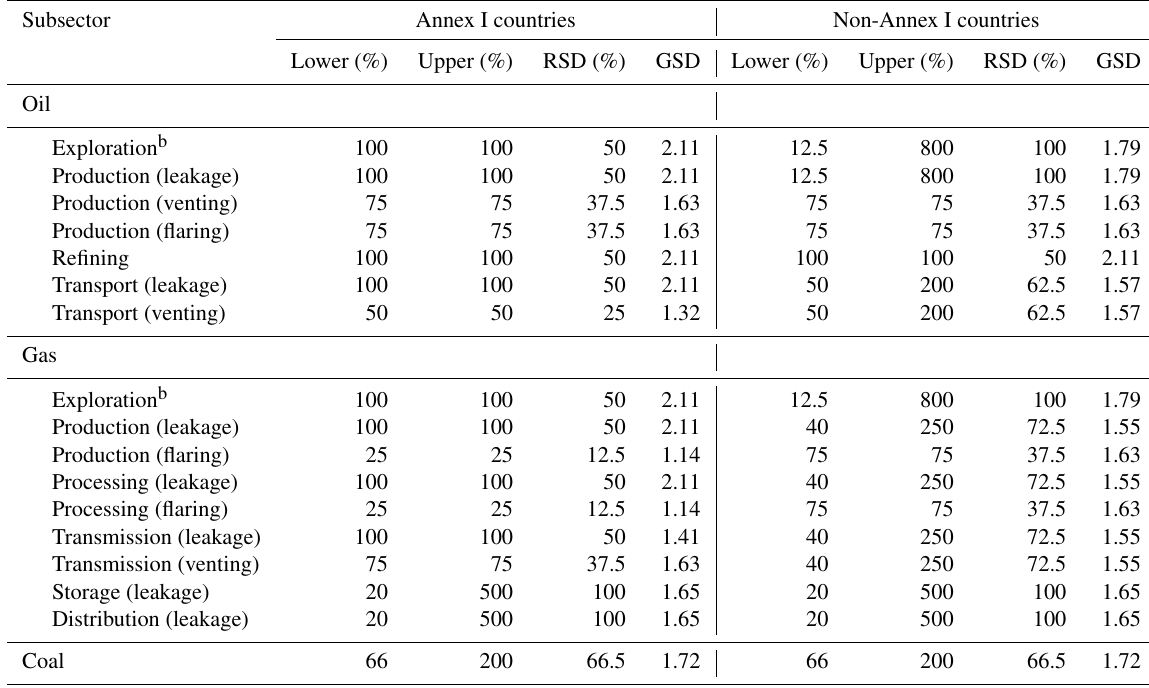
Table 1. Uncertainty ranges for IPCC emission factors and corresponding error standard deviations a .